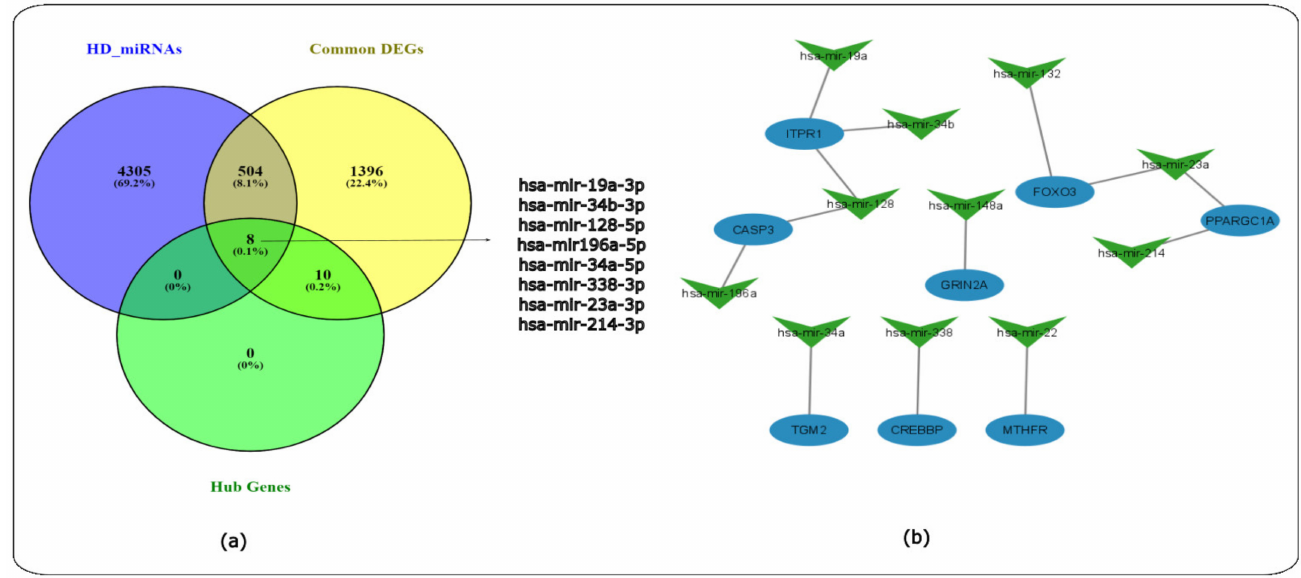
Figure 14. Venn diagram and miRNA-gene network for HD. ( a ) Venn diagram indicating the miRNA gene targets, the DEGs identified for all the HD datasets and the 18 hub genes, ( b ) miRNA-gene network where green V-shaped nodes represent the miRNAs and the blue circular nodes represent the eight common